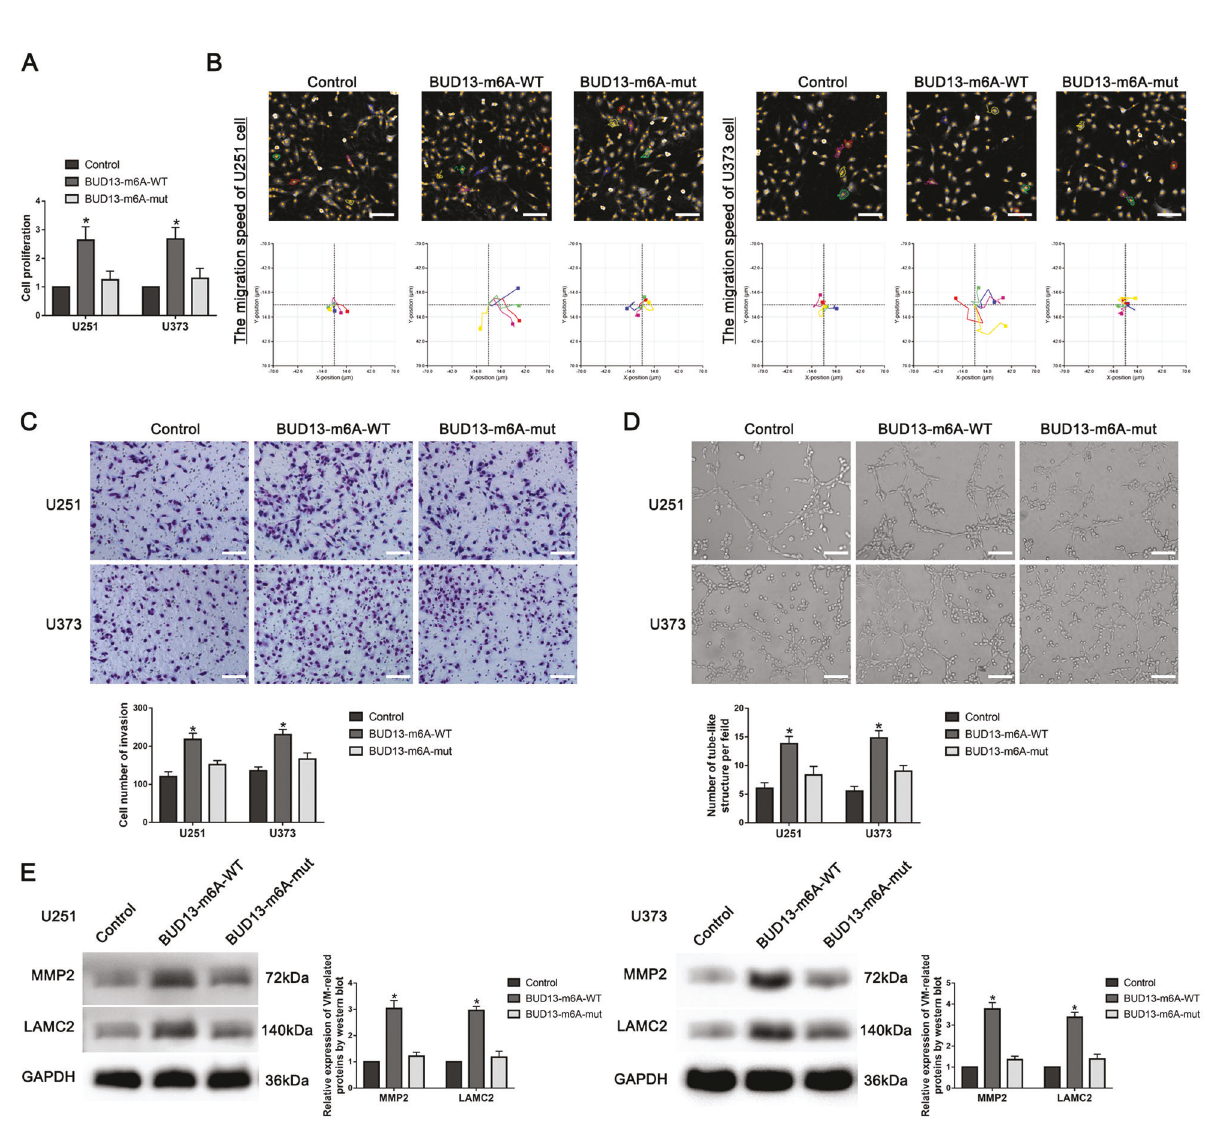
Fig. 2 Effects of BUD13 m6A methylation site on VM formation in GBM cells. A The effect of BUD13 m6A methylation site on the proliferation of U251 and U373 cells was detected by CCK8 assay. Data are presented as mean ± SD ( n = 3). * P < 0.05, compared with the Control group. B Hstudio M4 was used to detect the effect of BUD13 m6A methylation site on the migration of U251 and U373 cells ( n = 5). C Transwell assay was used to detect the effect of BUD13 m6A methylation site on the invasion of U251 and U373 cells. Data are presented as mean ± SD ( n = 3). * P < 0.05, compared with the Control group. D Three-dimensional tube formation assay was used to detect the effect of BUD13 m6A methylation site on the tube formation of U251 and U373 cells. Data are presented as mean ± SD ( n = 3). * P < 0.05, compared with the Control group. E Western blot was used to detect the effect of BUD13 m6A methylation site on the expression of VM-related proteins MMP2 and LAMC2 in U251 and U373 cells. Data are presented as mean ± SD ( n = 3). * P < 0.05, compared with the Control